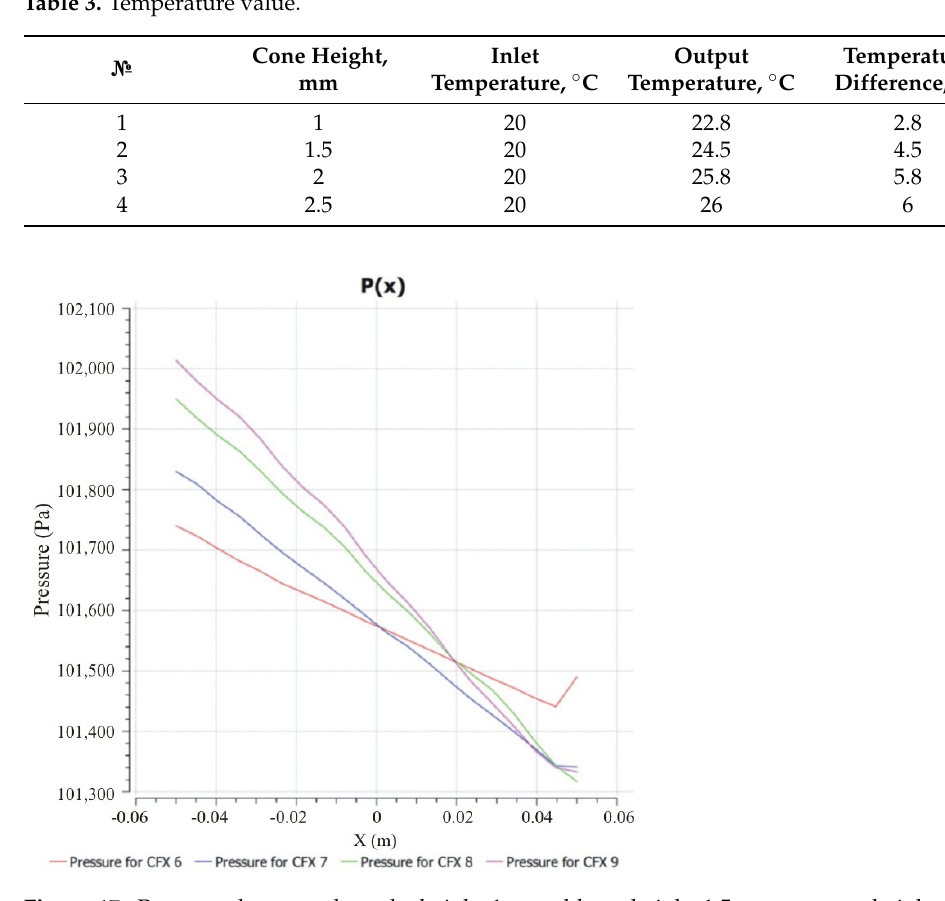
Figure 17. Pressure drop graph: red—height 1 mm; blue—height 1.5 mm; green—height 2 mm; purple—height 2.5 mm.